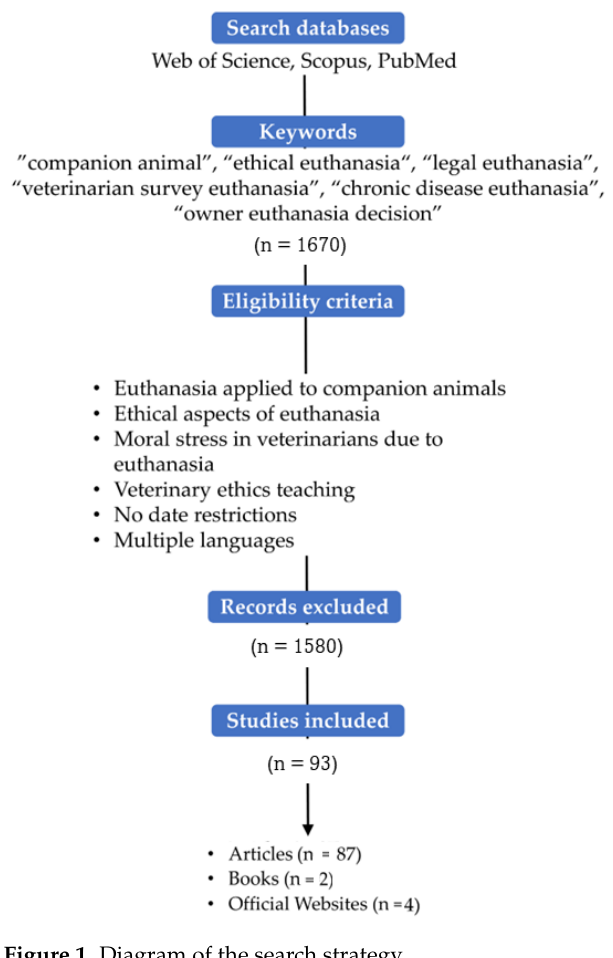
Figure 1. Diagram of the search strategy.